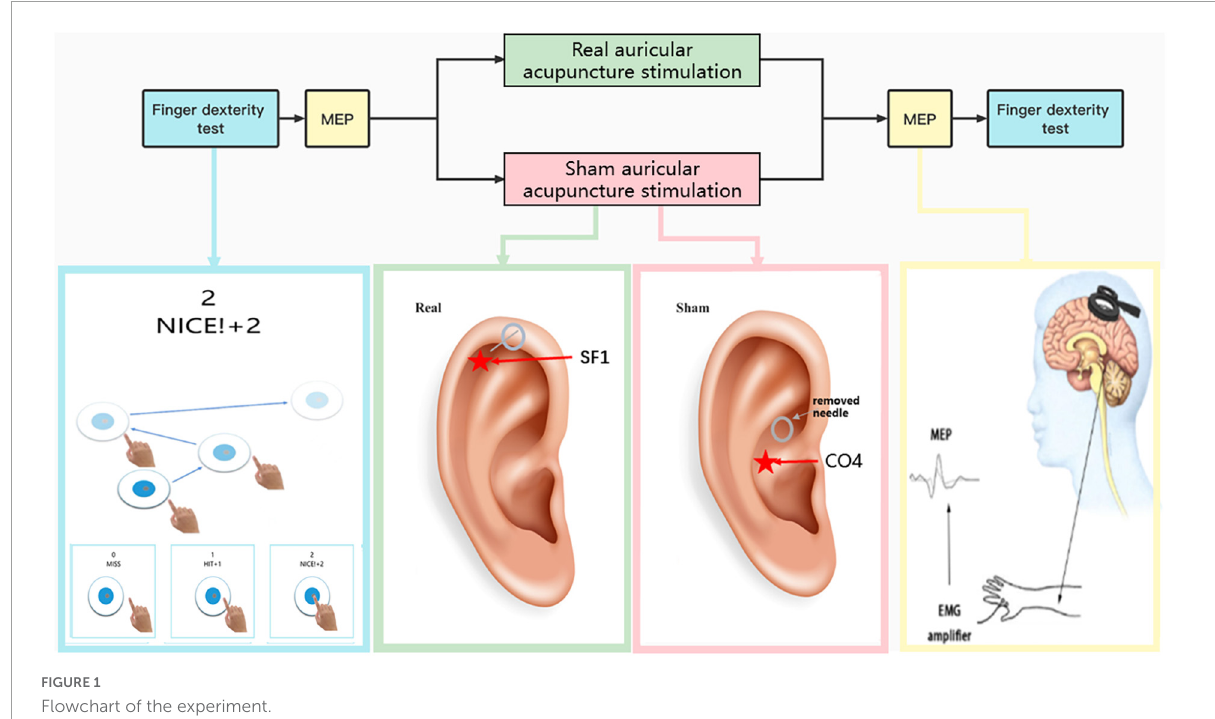
FIGURE1 Flowchart of the experiment.